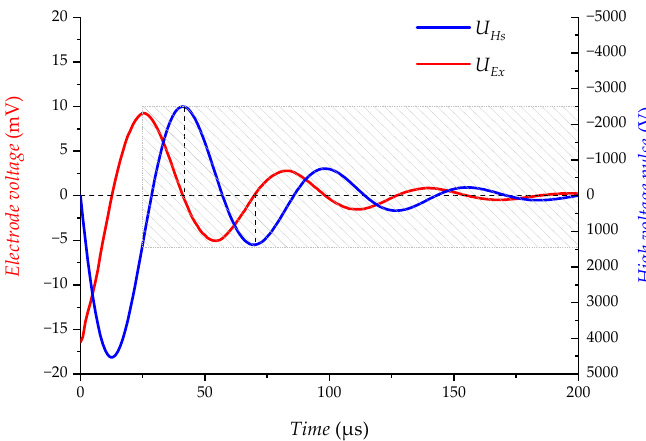
Figure 13. Time domain diagram of U Ex and U Hs (simulation). Figure 14 shows the frequency domain simulation of the U Ex and the U Hs . The frequency-amplitude characteristics of the electrical interference U Ex and the high-voltage pulses U Hs match very well, indicating that the frequency components of the electrical interference originate from the high-voltage pulses. The main component of the electrical interference falls in the frequency band range of (2~22) kHz, because High voltage pulses with high power excite the transmitting transducer to produce acoustic waves while also excite strong electrical interference.